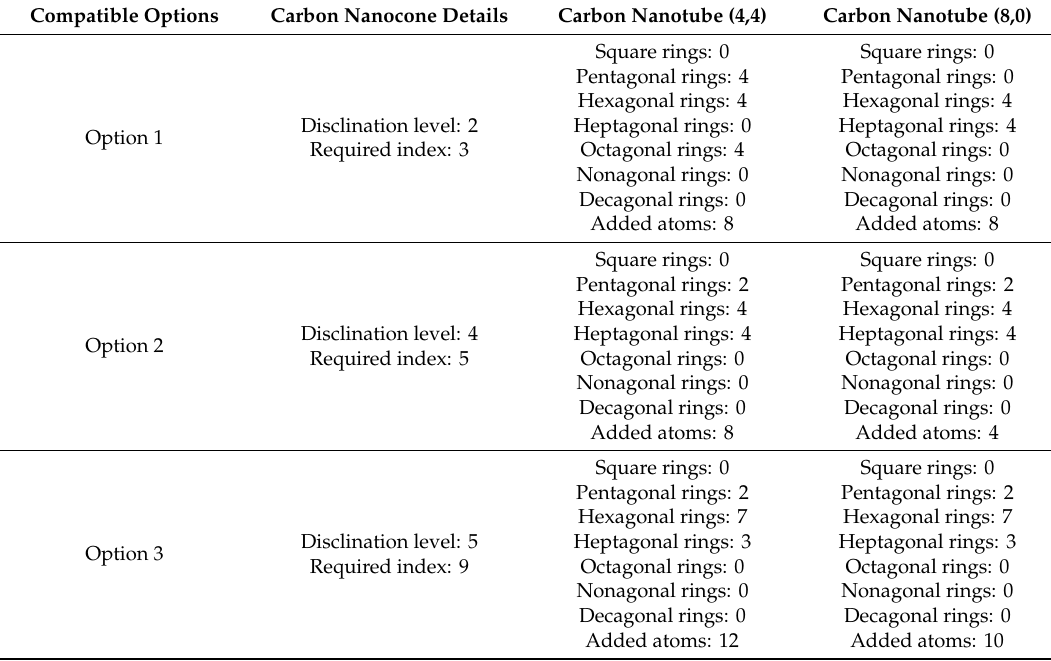
Table 2. Rings formed in the junction between the carbon nanotube and the carbon nanocone.